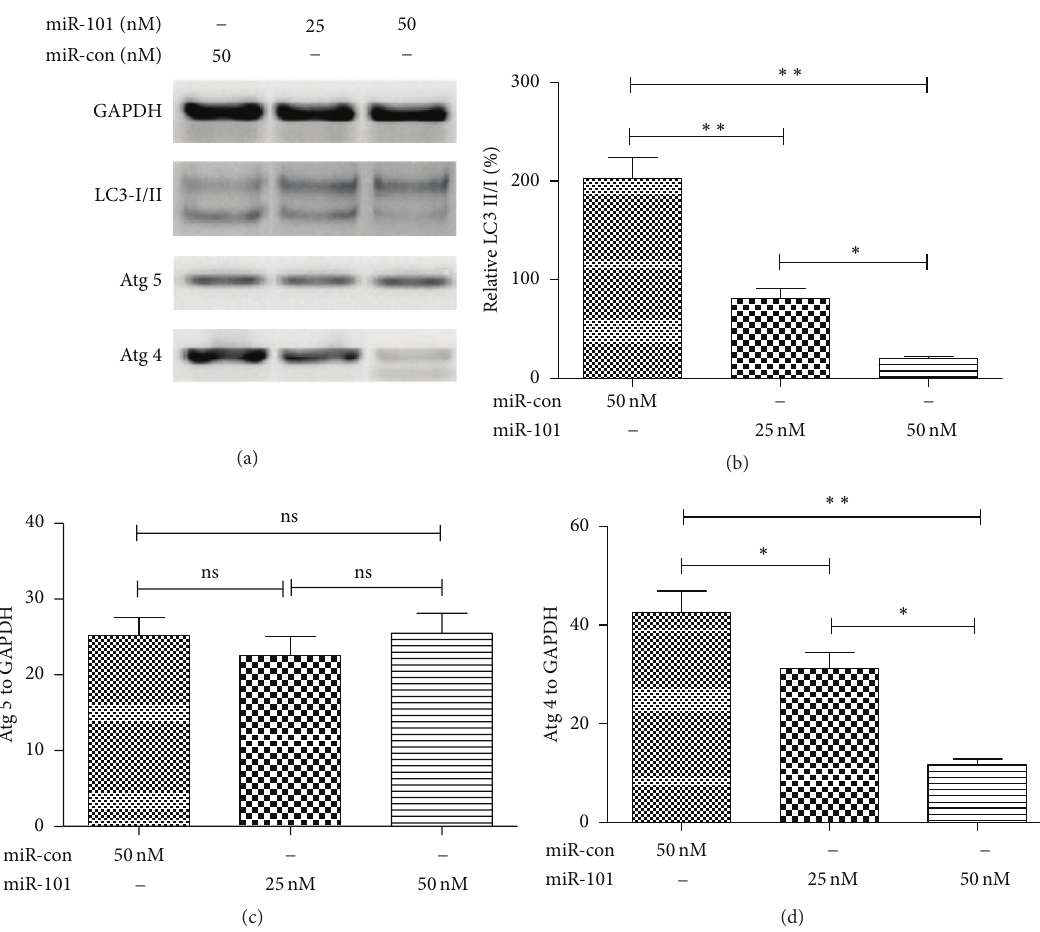
Figure 4: MiR-101 inhibits conversion of LC3-I to LC3-II and inhibits Atg 4 expression. (a) Western blotting results of Dox-treated U-2 OS cells simultaneously with miR control or miR-101 mimics transfection. (b) The conversion of LC3-I to LC3-II after miR-101 mimics or miR control transfection; (c) and (d) the percentage of Atg 5 or At 4 expression to GAPDH after miR-101 or miR control transfection ( ∗ 𝑃 < 0.05 , ∗∗ 𝑃 < 0.01 , and ∗∗∗ 𝑃 < 0.001 ). All results were from three independently performed